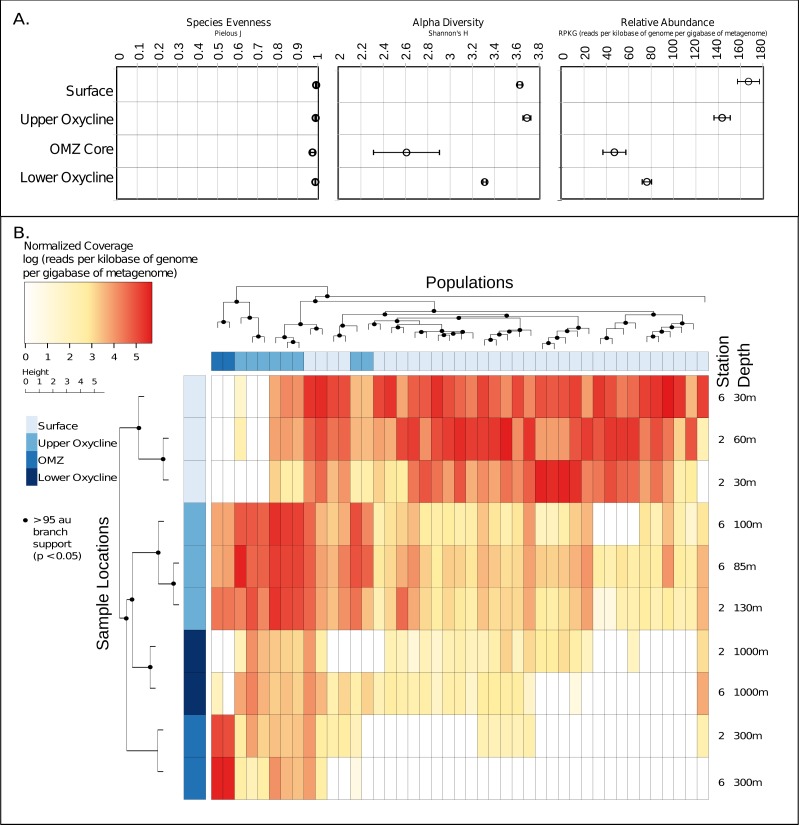
Ecology and relative abundance of putative archaeal viruses.(A) Evenness (Pielou’s J), alpha diversity (Shannon-Weiner index), and relative abundance, at each sample site and depth. The relative abundance and alpha diversity of putative ETNP archaeal virus populations tracks gradients in oxygen concentration, with the highest abundances found in habitats with high oxygen and vice versa. Viral evenness is high and relatively consistent in each. (B) Relative abundance of archaeal virus populations at each station and sample depth determined by mapping quality trimmed reads to the 43 archaeal virus populations. The units of the abundance measurements are the logarithm (base 10) of the read coverage, normalized by the number of bases in the trimmed read file and contig size. The dendrogram on the x-axis represents the 43 ETNP archaeal virus populations, clustered by relative abundance per sample, and the dendrogram on the y-axis represents the sample locations grouped according to similarities in contig composition. Nodes with approximately unbiased (AU) bootstrapping values greater then 95 (p ≤ 0.05) are displayed with a dot.